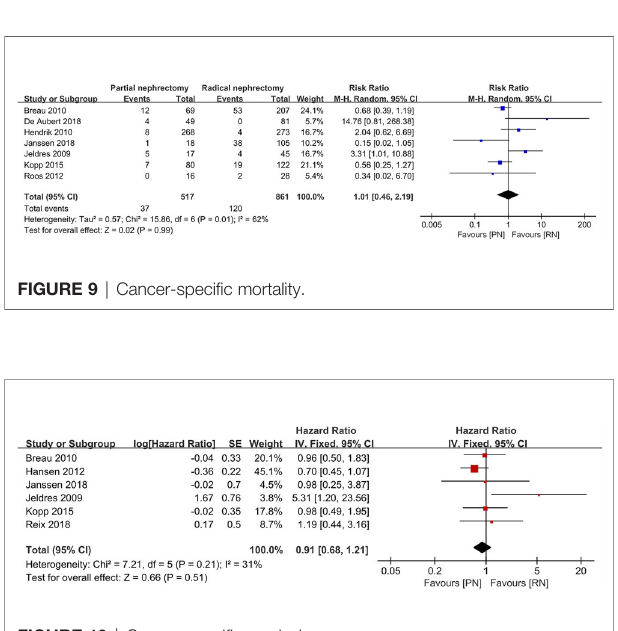
FIGURE 10 | Cancer-speci fi c survival.